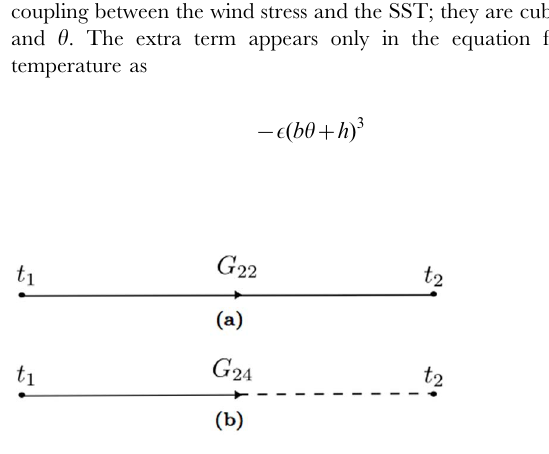
Figure 5. The propagators of the system: (a) the propagator for the variables ( z 2 , z 2 ) (b) the propagator for the variables ( z 2 , w 2 ) . A corresponding propagator can be obtained exchanging 2 and 4.